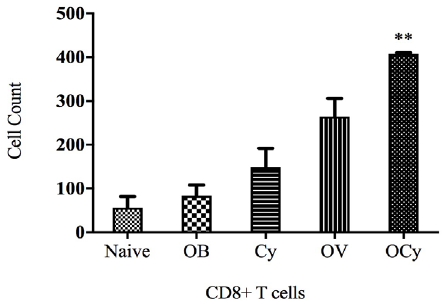
Figure 9. Analysis of the CD8+ T cell population level in the naïve mice and those administered blank microparticles (OB), cyclophosphamide (i.p., 50 mg/kg (Cy)), oral vaccine microparticles (OV), and a combination of vaccine and cyclophosphamide (OCy). The CD8+ T cell population was significantly higher in mice administered low-dose cyclophosphamide and oral vaccination compared with control groups (** p < 0.01).